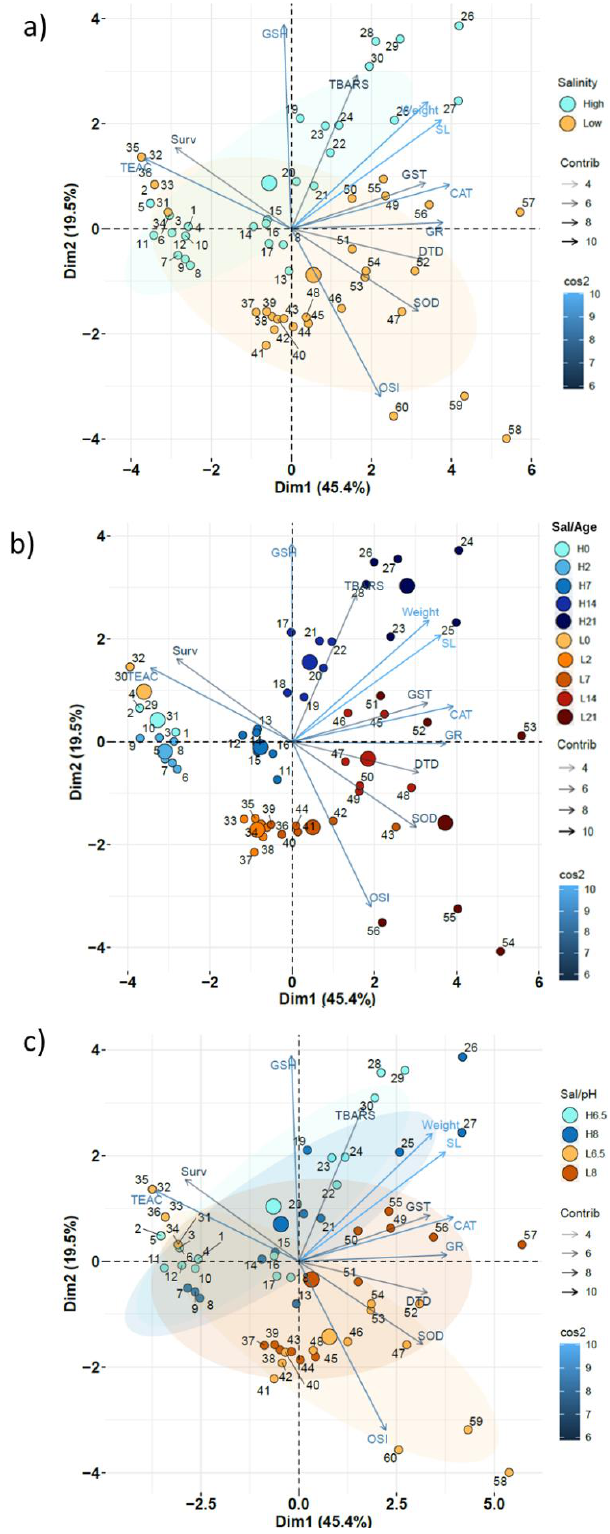
Figure 1. Trial 1 — PCA plots of survival, enzymatic activities, and enzymatic indices in seahorse juveniles H. reidi. Sample IDs and the variables with the highest contributions (cos 2 > 0.5) are indicated. Ellipses correspond to centroid values ± 1 s.d. (shaded areas). ( a ) Seawater (SW = High — 33) vs. brackish water (BW = Low — 11) groups. ( b ) All salinity levels (33 and 11) and ages (0 – 21 DAR). ( c ): All salinity (SW — 33 and BW — 11) and pH (6.5 and 8) levels.